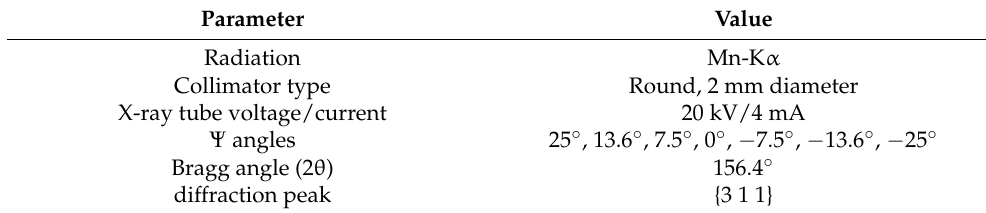
Table 3. The parameters used in residual stress measurements.